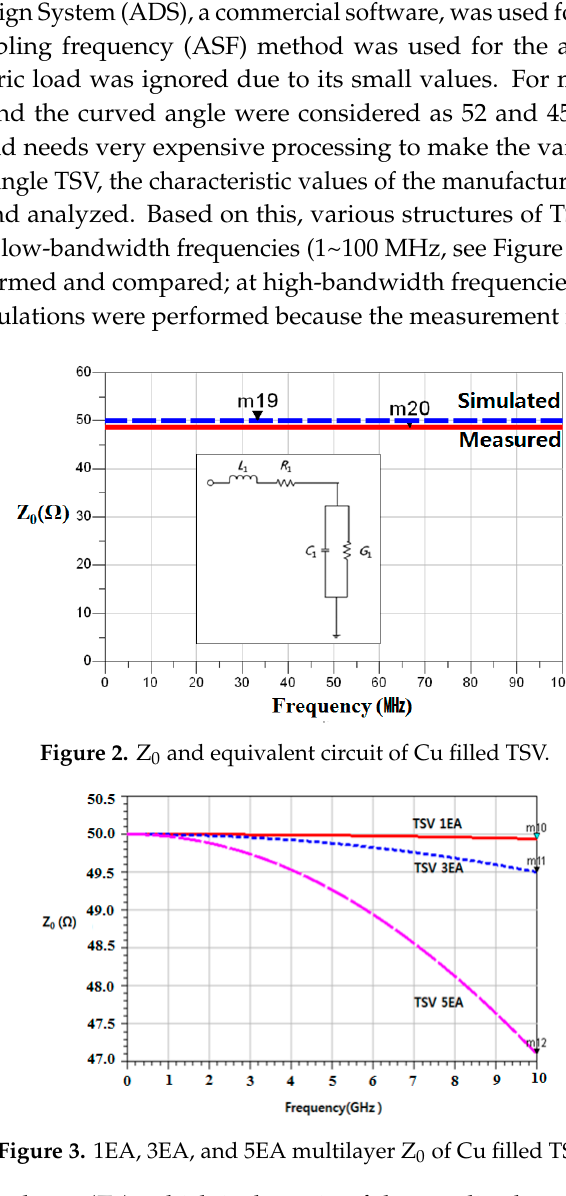
Figure 4. Different TSV shapes considered in the simulation.